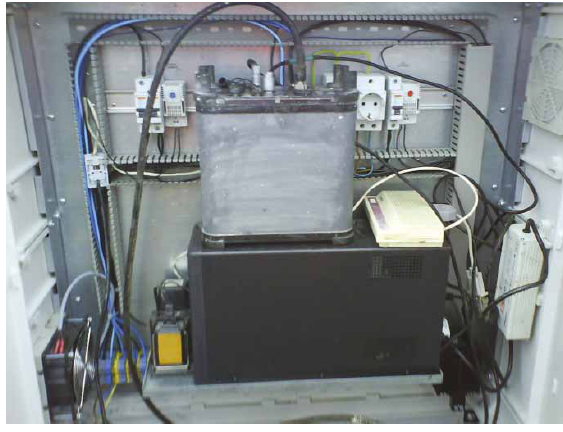
Fig. 5. VLNS GPS receiver